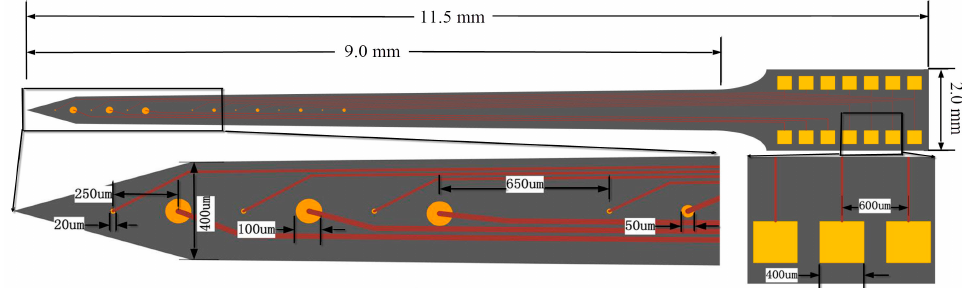
Figure 2. Schematic diagram of the designed microelectrode array.